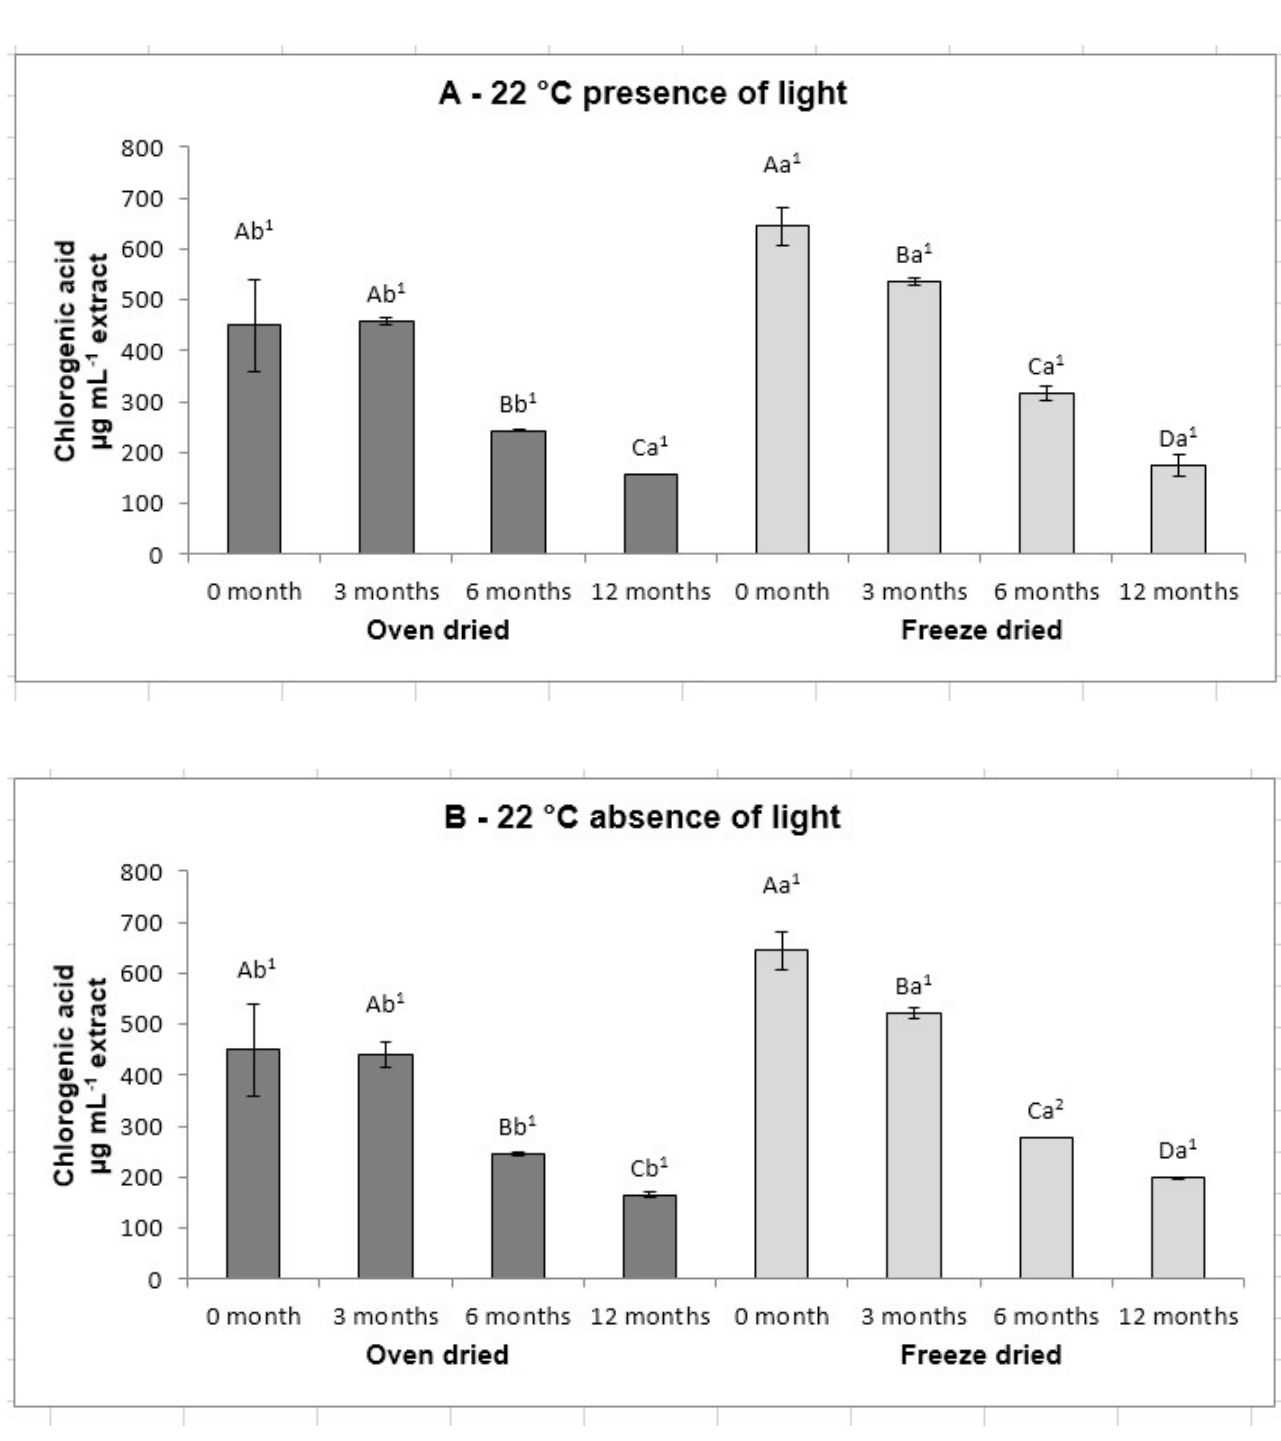
FIGURE 2 - Variation of the content of chlorogenic acid in extracts of oven dried and freeze-dried M. glomerata leaves. Long term stability study at 22 ºC in the presence of light (A) and absence of light (B). Capital letters indicate statistically significant (p<0.05) differences within the same drying method (0, 3, 6 and 12 months). Lowercase letters indicate statistically significant (p<0.05) differences between drying methods at the same time. Numerals indicate statistically significant (p<0.05) differences between storage with and without light. Experiment performed in triplicate. Error bars indicate standard